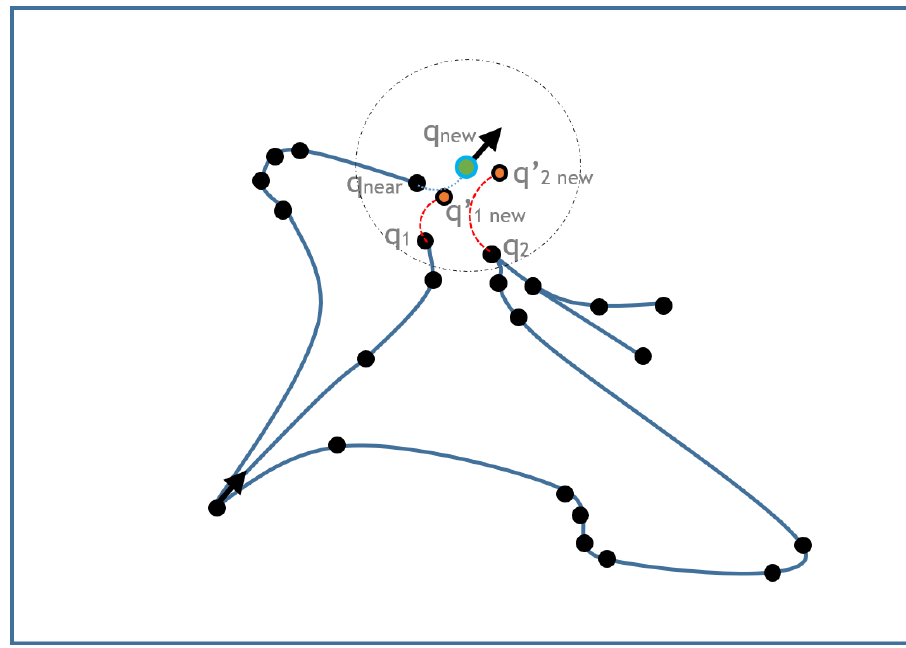
Figure 11. Connection